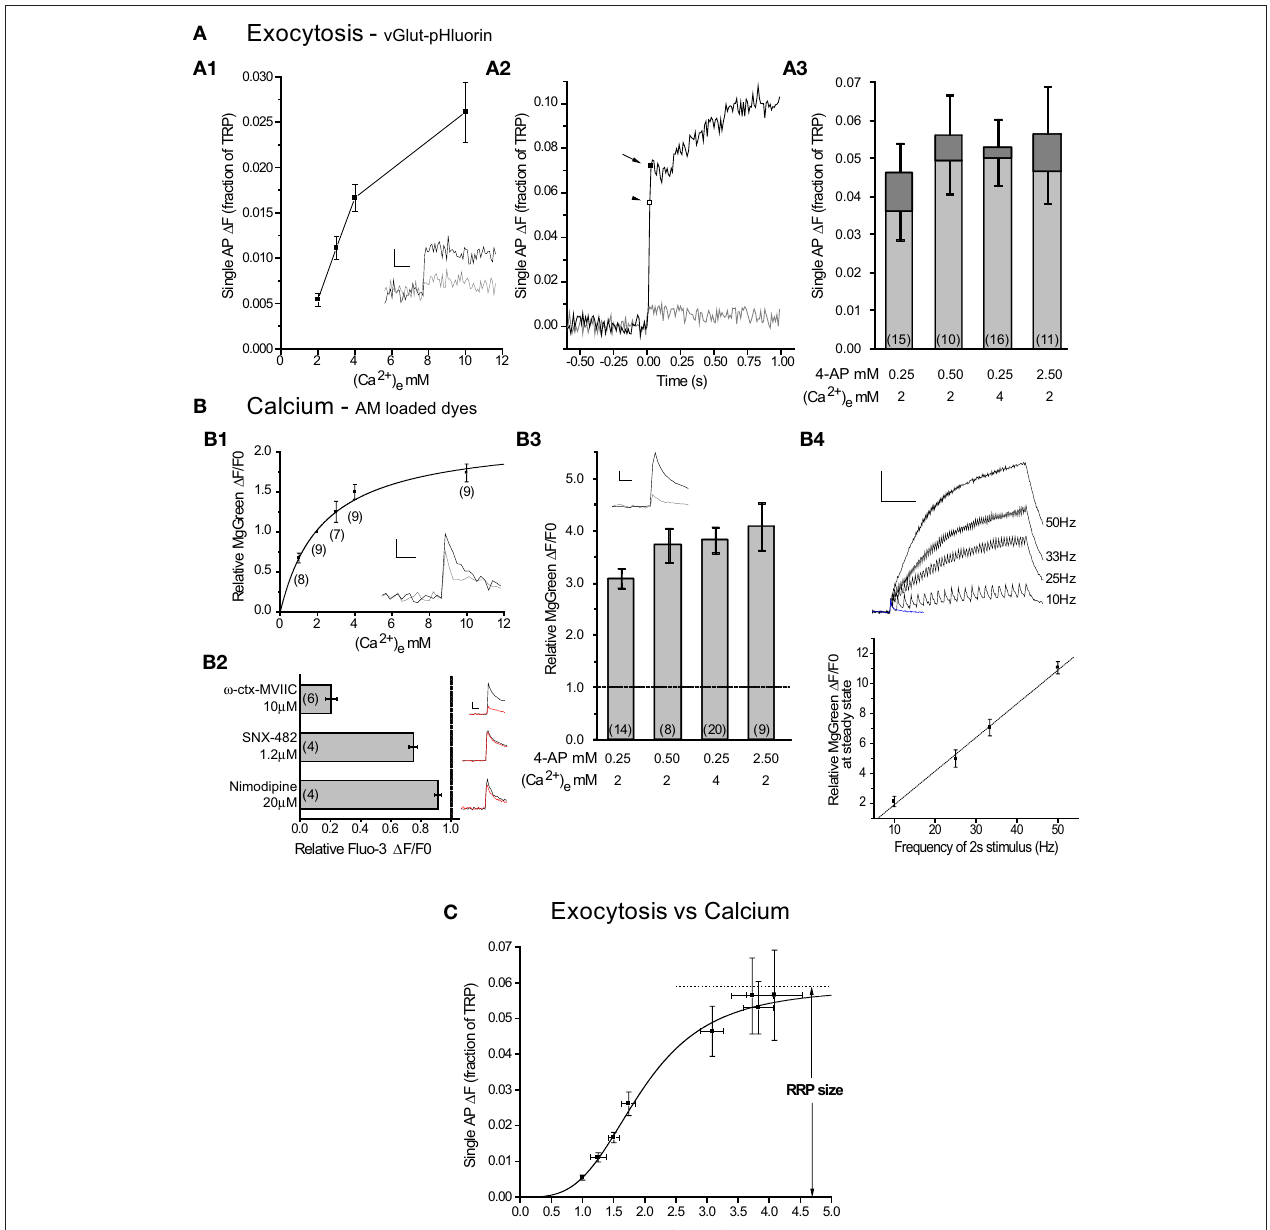
channel toxins on single AP responses measured with Fluo-3 AM. Beside each Figure 2 | Single APs cause exocytosis of the entire rrP in conditions with column there is an average control (black) and toxin (red) trace from a representative large intracellular calcium increases. (A1) Exocytosis in response to 1 AP as a experiment ( n = 3–5 trials each). Scale bar = 20% ∆ F / F 0, 50 ms (B3) Increases in function of extracellular calcium ( n = 14 cells). Inset : representative individual trials at intracellular calcium concentration in response to 1 AP relative to control in different 2 mM (gray) and 4 mM (black) from one cell. Scale bar = 1% of TRP, 100 ms. (A2) 4-AP and extracellular calcium conditions. Inset : response to control (gray, n = 5 trials) Representative experiment showing responses to a single AP under control and 4-AP (black, n = 13 trials) from a representative experiment with 2.5 mM 4-AP. conditions (2 mM external calcium, gray) and with 2.5 mM 4-AP (black). Note the Scale bar = 2% ∆ F / F 0, 50 ms. (B4) Top : representative experiment showing presence of fast (arrow) and slow subcomponents of delayed release after the end of responses to 1 AP (blue) and 2 s stimuli at 10, 25, 33 and 50 Hz (black). Scale stimulus-locked exocytosis (arrowhead). n = 7 and 3 trials for control and 4-AP bar = 10% ∆ F / F 0, 0.5 s. Traces are averages of 3 trials for 2 s stimuli and 13 trials for respectively. (A3) Average responses to single APs under different 4-AP and the 1 AP stimulus. Bottom: average steady state ∆ F / F 0 at the end of 2 s stimuli of extracellular calcium conditions. The bars show the stimulus-locked (light gray) and varying frequencies ( n = 4 experiments). Responses are normalized to the single AP fast delayed (dark gray) components of exocytosis with their SEs. (B1) Average peak in each experiment. Line shows fit ( P < 0.001, R 2 = 0.995). (C) Exocytosis as a relative peak ∆ F / F 0 as a function of external calcium across several experiments. The function of the relative increase in internal calcium concentration ( n = 10–16 vG-pH line is a fit (to the measurements) by a single site binding model (equation (4), experiments, n = 9–20 MgGreen experiments). The line shows the fit to a K = 2.3 ± 0.4 mM, R = 2.2 ± 0.2). Inset : responses to 1 AP at 2 mM (gray) and m max generalized Hill model (Eq. 3, RRP = 5.9 ± 0.7% of TRP, n = 3.4 ± 0.4, K = 1.9 ± 4 mM (black) in a representative experiment ( n = 4 trials each). (B2) Effects of calcium